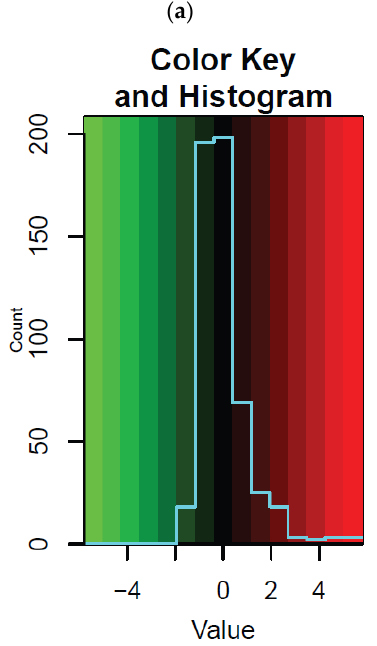
( b ) Figure 3. Heatmaps of antibodies with statistically significant differences ( p < 0.05) according to antibiotic exposure: ( a ) Z − Score Baseline antibodies; ( b ) Z − Score 6 week antibodies.